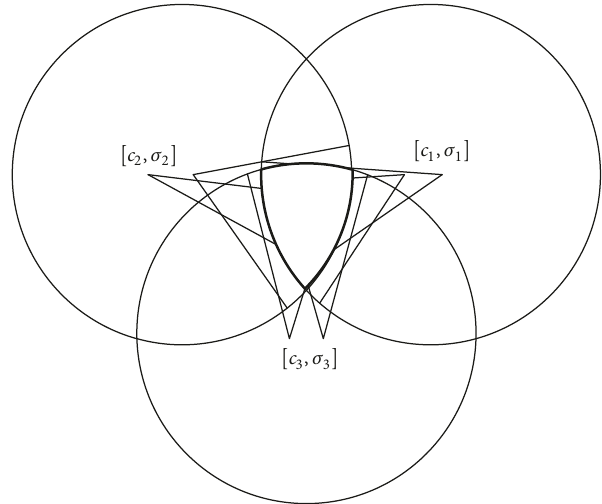
Figure 8: Circles of equal radii intersecting and forming a circular